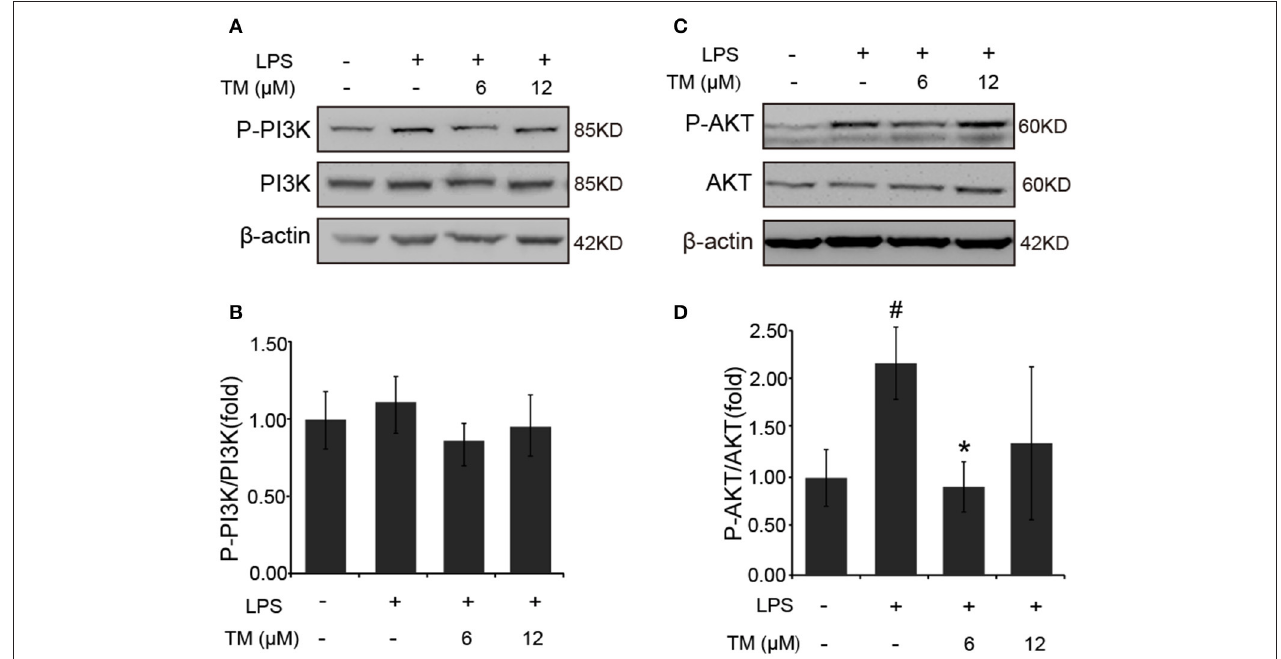
FIGURE 6 | TM-pretreatment significantly decreases AKT phosphorylation in LPS-induced BV-2 cells. (A,B) Immunoblot images (A) and quantifications (B) show that both TM-pretreatment and LPS-stimulation did not affect PI3K expression in BV2 cells. (C,D) Immunoblot images (C) and quantifications (D) show that TM-pretreatment lead to a reduction of AKT phosphorylation induced by LPS. The results are represented as the mean ± SD of at least three independent experiments ( N ≥ 3). * p < 0.05 compared with the LPS; # p < 0.05 compared with the control. The p- values were calculated by One-way ANOVA followed by Bonferroni’s post-hoc